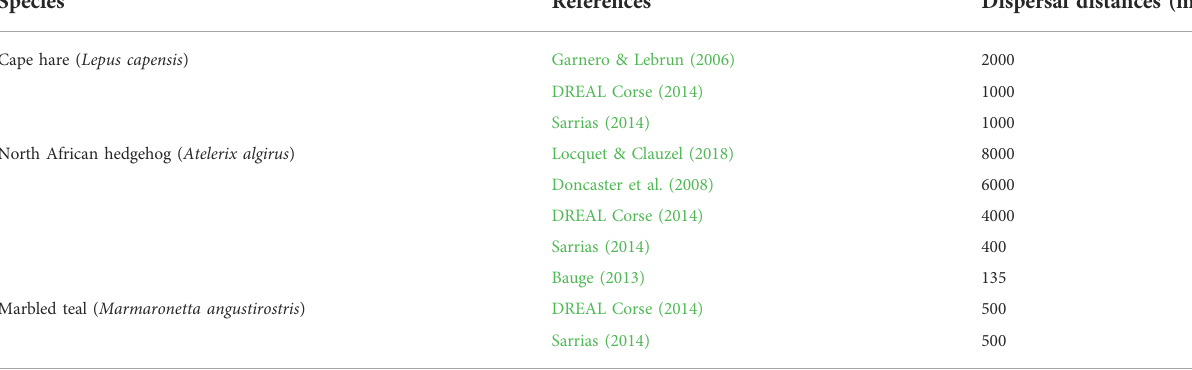
TABLE 4 Examples of dispersal distances for representative species from the literature.